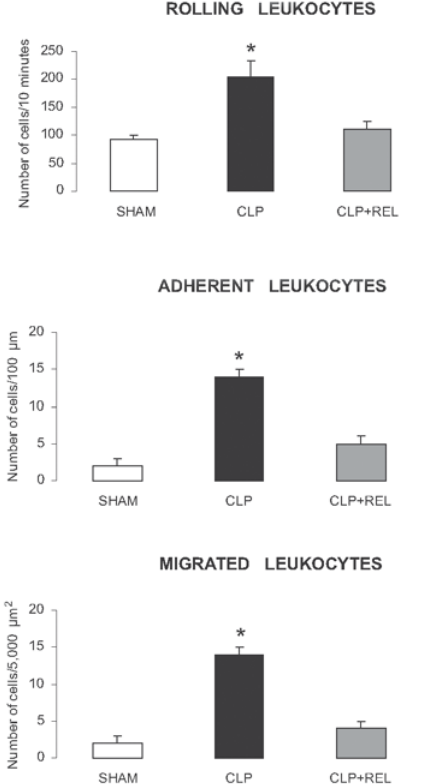
Figure 2 - Number of rolling leukocytes/10 minutes, adherent leukocytes/ 100 µm venule length, and migrated leukocytes/5,000 µm 2 in rat mesenteric microcirculation. Rats were SHAM-operated (SHAM, n = 6), submitted to cecal ligation and puncture (CLP, n = 7) and to CLP + necrotic tissue resection/peritoneal lavage (REL, n = 6). Statistical analyses were performed using Kruskal-Wallis analysis and Dunn´s test and showed significant differences (* P < .05) among CLP vs SHAM and CLP+REL